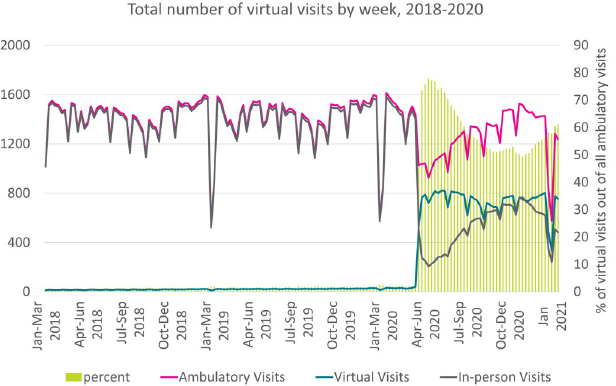
Fig 1. Total number of virtual and in-person visits (line) and percent virtual care use out of total ambulatory care (bars). � All ambulatory visits = both in-person and virtual.